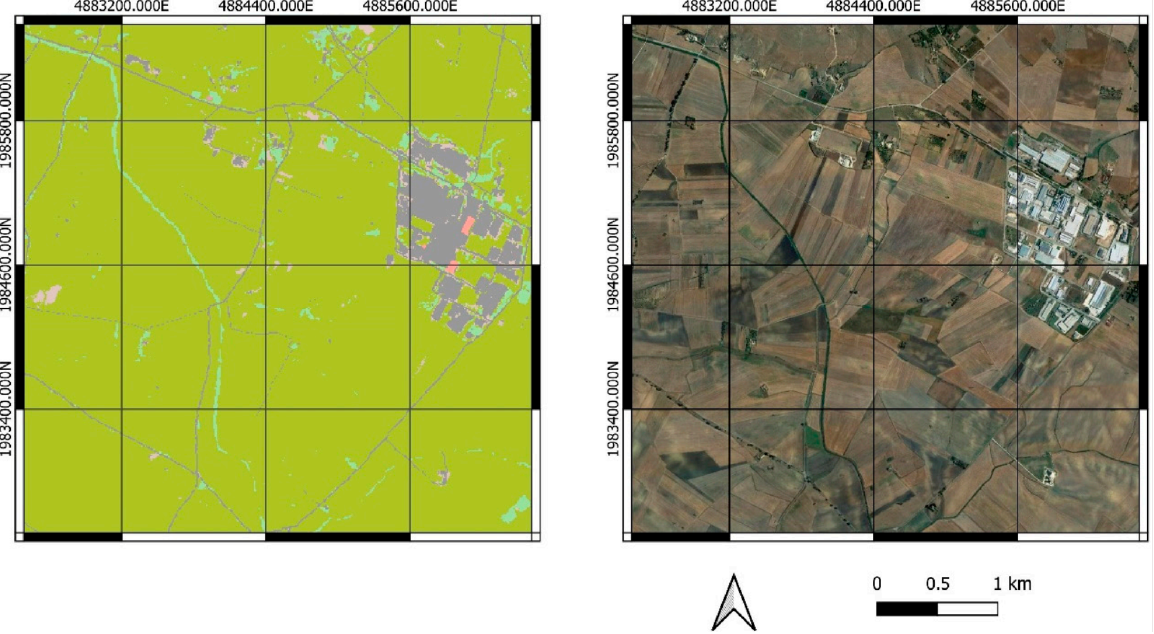
Figure 10. Periodic